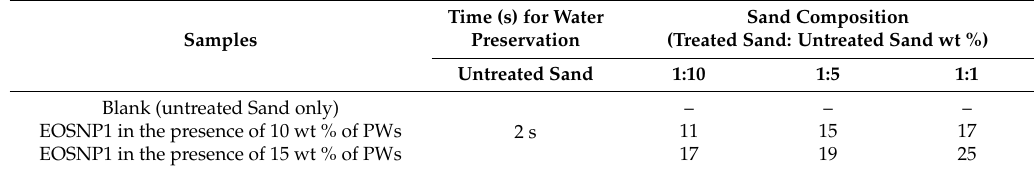
Table 4. Efficiency of the mixed sand with the different ratios of sand treated with the EOSNP1, on the preservation of water. Time (s) for Water Sand Composition Samples Preservation (Treated Sand: Untreated Sand wt